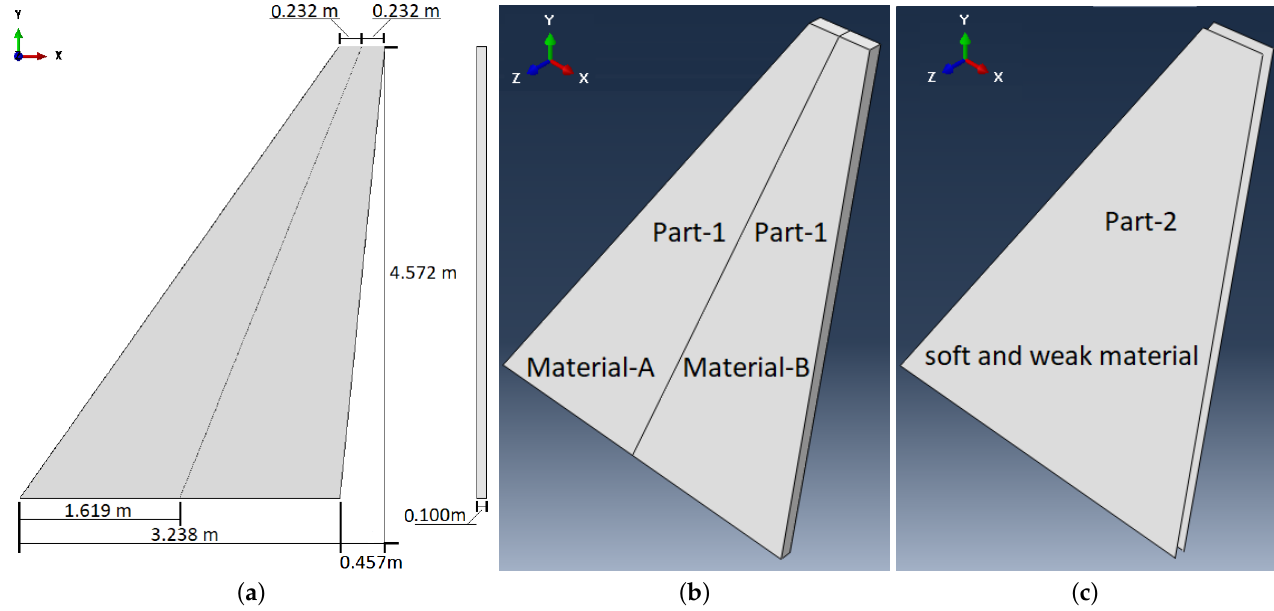
Figure 2. Full scale model: ( a ) dimensions and material application; ( b ) internal structure-solid model; ( c ) external surface-shell model (2 faces).